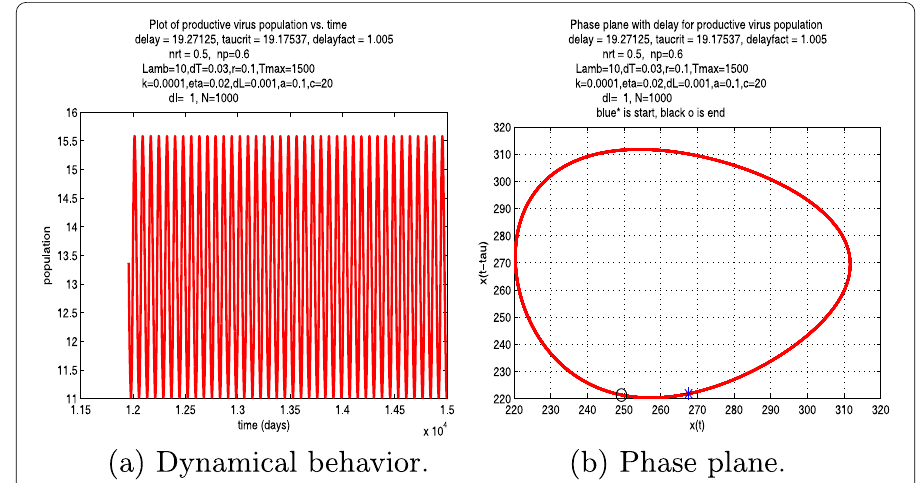
Figure 4 Limit cycle behavior of infectious free virus population for data set 1 for time delay greater than critical time for n rt = 0.5, n p =